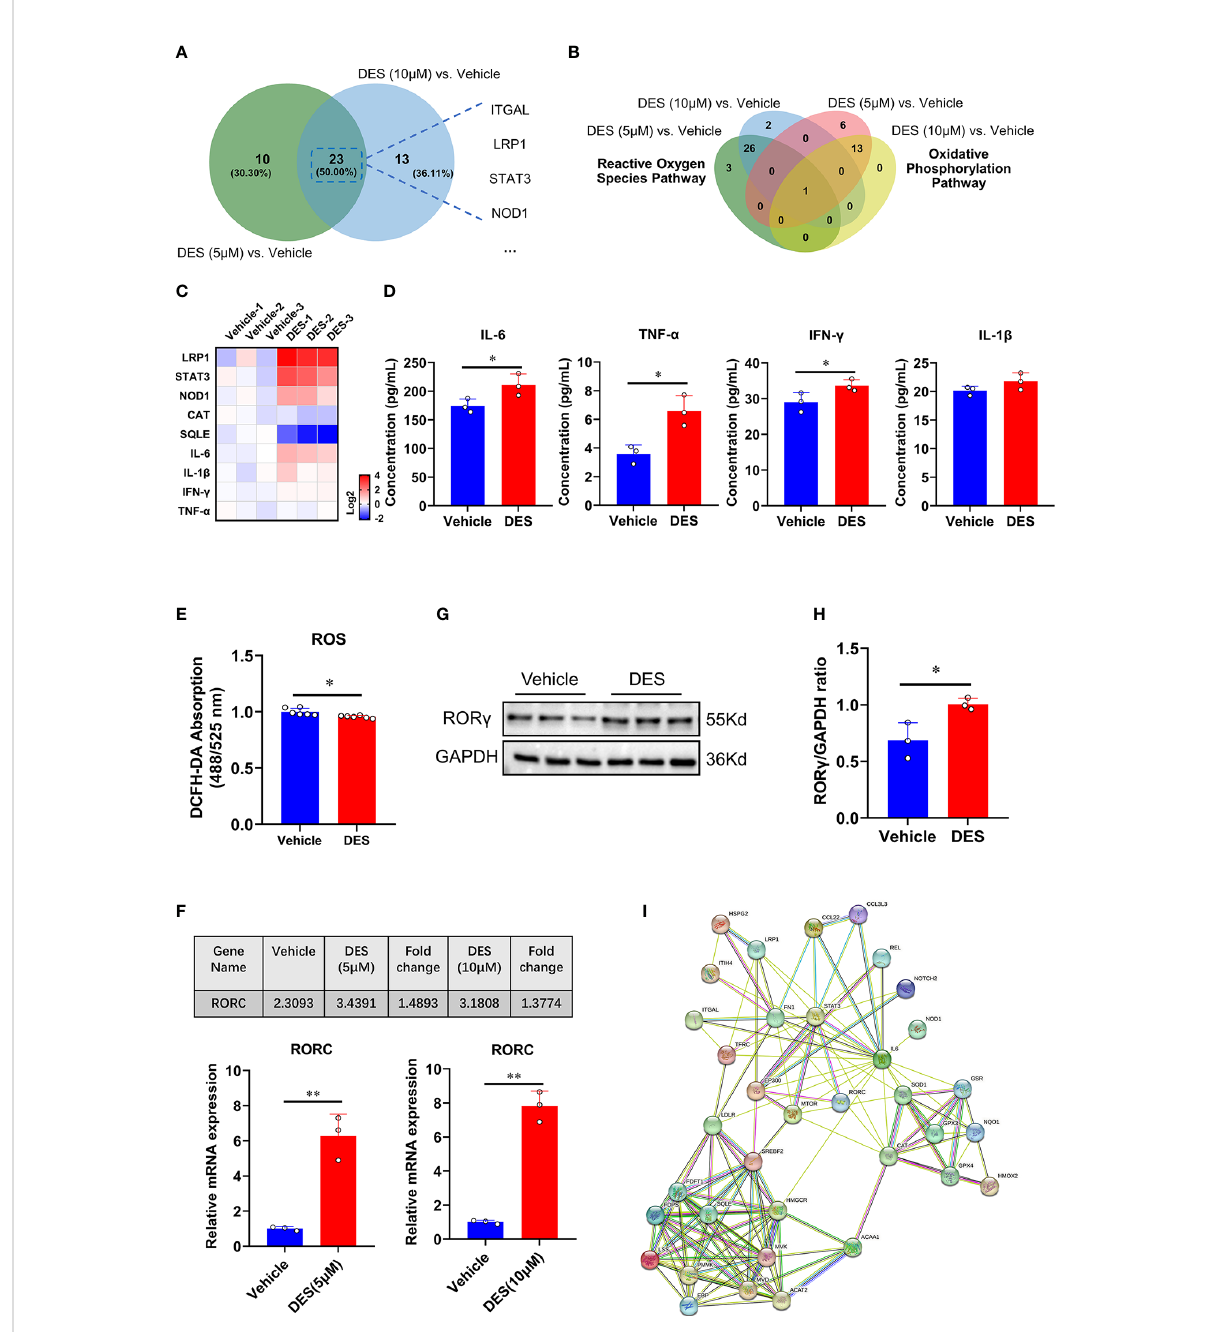
FIGURE 3 ROR g acts as a potential factor to regulate in fl ammatory response and oxidative stress pathways. (A) Venn diagram of the genes with signi fi cantly differential expression (Log 2 fold change > 0.5) shared by DES (5 m M) versus vehicle and DES (10 m M) versus vehicle in in fl ammatory response pathway. (B) Venn diagram of the genes with signi fi cantly differential expression (Log 2 fold change < -0.5) shared by DES (5 m M) versus vehicle and DES (10 m M) versus vehicle in ROS and OXPHOS pathways. (C) A heatmap shows fold change (in Log 2 ) of 9 genes determined by qRT-PCR analysis in IPI-2I treated with DES (10 m M) for 72 h (D) Protein levels of IL-6, TNF- a , IFN- g , and IL-1 b in the cell supernatant. (E) Measurement of ROS (DCFH-DA) fl uorescence abundances with DES (10 m M) treatment. (F) RNA-seq (FPKM value) and qRT-PCR analysis of RORC gene expression by DES (5 m M/10 m M) treatment. (G) Western blot analysis of ROR g protein expression in the DES (10 m M) group. (H) The relative protein expression of ROR g was normalized to the GAPDH. (I) The interactions among in fl ammatory response, ROS, and cholesterol homeostasis pathway key proteins involved in ROR g transcriptional regulation were predicted by STRING-ELIXIR analysis. The data are shown as the means ± SD, n ≥ 3 per group. The experiments were repeated 3 times. * P < 0.05, ** P < 0.01, using Student ’ s t -test